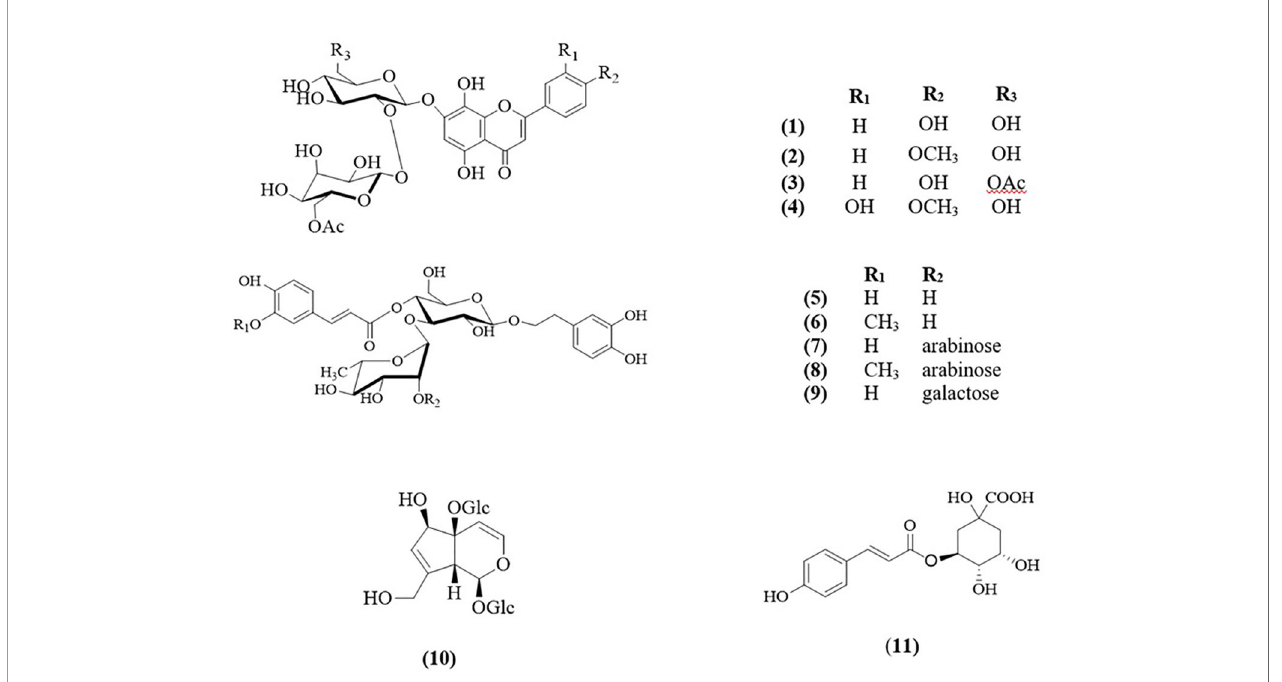
FIGURE 2 | Structures of isolated compounds 1 – 11